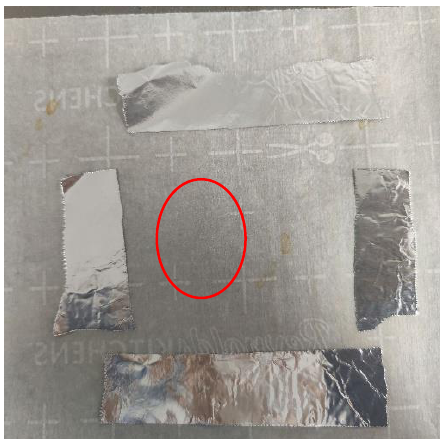
Figure 15. One 114 kGy PLA resin bead compressed under 6228 N, 193 ℃ /12 min. Remnant PLA resin almost invisible (encircled).